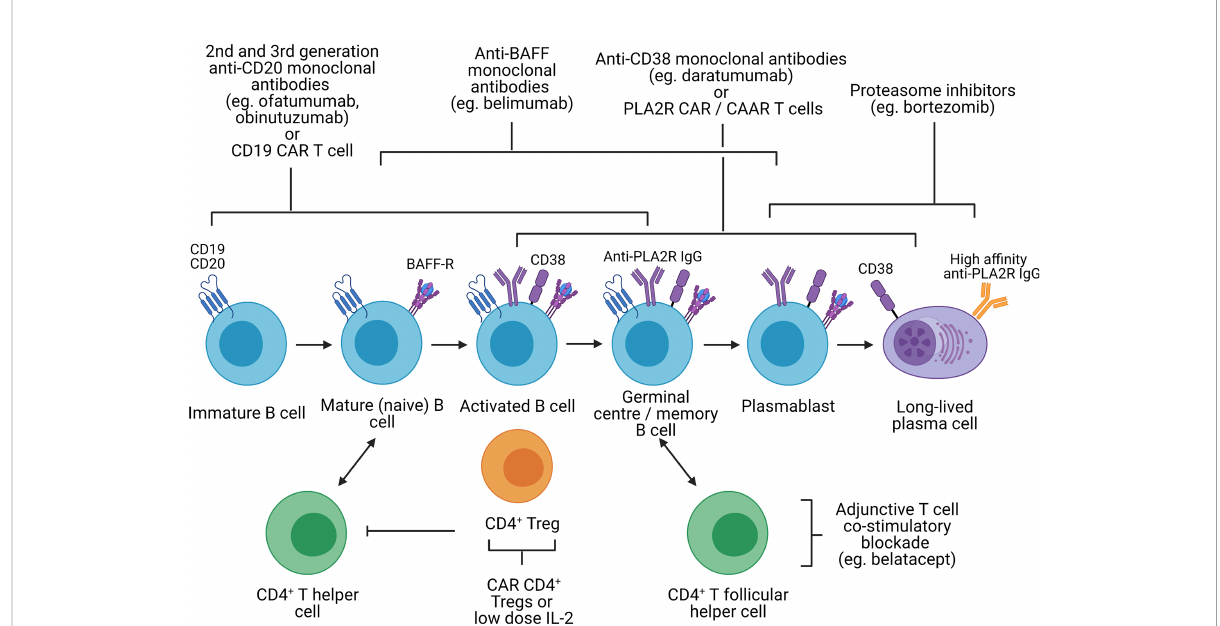
FIGURE 3 Potential immunological targets for novel therapeutics in primary membranous nephropathy. Created with BioRender.com. BAFF-R, B-cell activating factor receptor; CAR, chimeric antigen receptor; CAAR, chimeric autoantibody receptor; PLA2R, M-type phospholipase A2 receptor 1; Treg, regulatory T cell, In primary membranous nephropathy, autoreactive B cells produce autoantibodies targeting podocyte antigens (represented by PLA2R in this fi gure but also include thrombospondin type-1 domain-containing protein 7A, neural epidermal growth factor-like 1 protein, semaphorin 3B, protocadherin 7, high temperature requirement A serine peptidase 1, and netrin G1). These autoreactive B cells originate from the bone marrow, mature from immature B cells to mature B cells, become activated upon interaction with CD4 + T helper cells (via cytokines and CD40 ligation) and undergo isotype switching. Activated B cells subsequently migrate to the germinal center of secondary lymphoid organs where they interact with CD4 + T follicular helper cells, resulting in B cell proliferation and somatic hypermutation, ultimately differentiating into plasmablast and long-lived plasma cells which secrete high-af fi nity autoantibodies. Immature, mature, activated and germinal center B cells express CD19 and CD20, which can be targeted by 2 nd and 3 rd generation anti-CD20 monoclonal antibodies (eg. ofatumumab and obinutuzumab), which may be superior to rituximab, or CD19 CAR T cells. However, in cases of primary membranous nephropathy resistant to 1 st generation anti-CD20 monoclonal antibodies (eg. rituximab) that respond to 2 nd or 3 rd generation anti-CD20 monoclonal antibodies, this may be due to changes in the CD20 antigen that may be restricted to autoreactive B cells. CD19 and CD20 are also not expressed